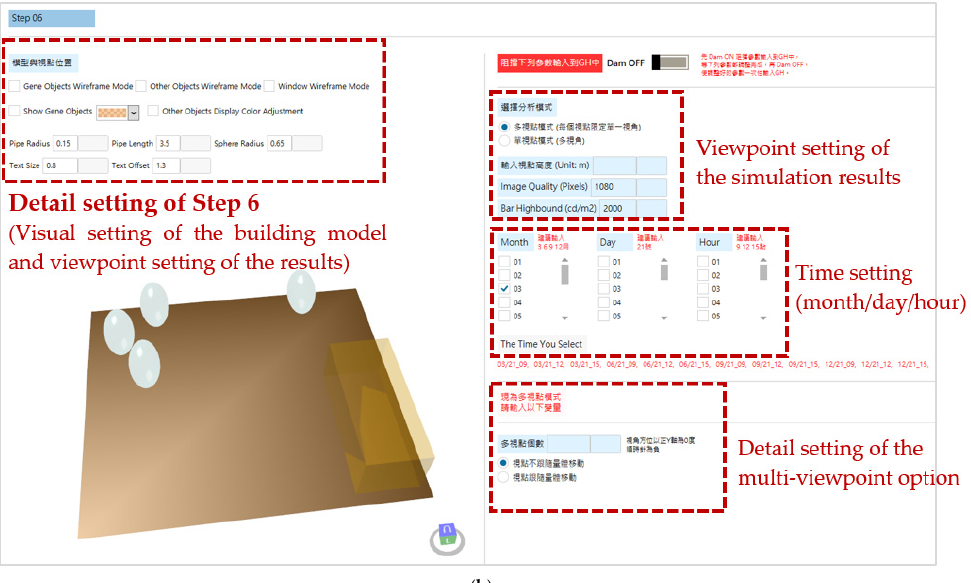
Figure 2. Simulation setting UI for DGP. ( a ) General simulation setting UI. ( b ) Custom simulation setting UI.